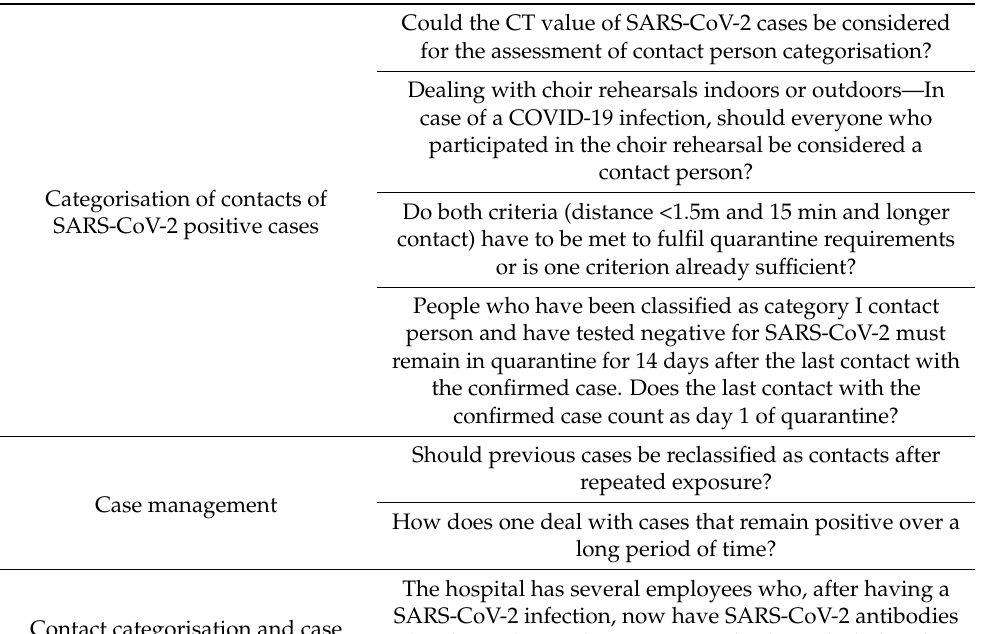
Table 2. Selection of questions from Containment Scouts to the Robert Koch Institute (first